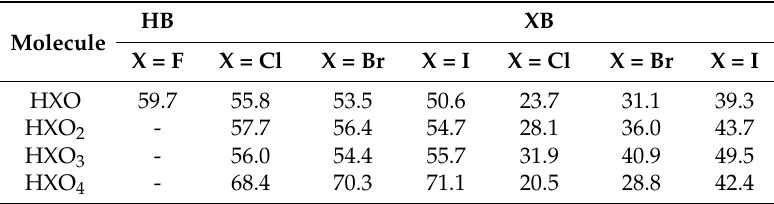
Figure 1. Molecular electrostatic potential (MEP) on the 0.001 a.u. electron density isosurface of the halogen oxoacids. Energy values in kcal · mol − 1 . Table 2. Molecular electrostatic potential values ( ∆ E in kcal · mol − 1 ) and interatomic distances (Å) of the hydrogen bonding (HB) and halogen bonding (XB) complexes with NH 3